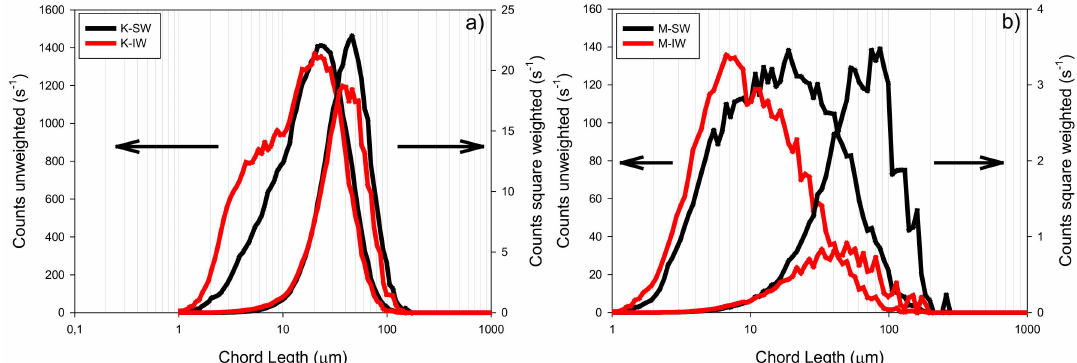
Figure 3. Unweighted and square-weighted chord-length distribution from ( a ) kaolin (K), and